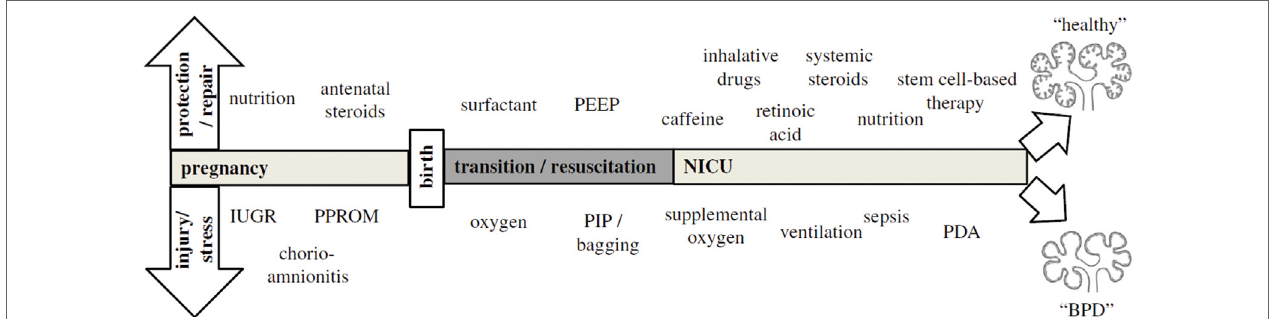
FigURe 1 | The pathogenesis of bronchopulmonary dysplasia (BPD) is highly multifactorial in nature, with a wide variety of pre- and postnatal exposures influencing lung development . Depending on the timing and combinations of exposures, BPD likely exists of multiple different pathophysiologies that manifest themselves in a similar way clinically. The top arrow represents exposures that may to a certain extent protect from BPD pathogenesis and promote repair, while the bottom arrow indicates exposures that injure the preterm lung and contribute to BPD pathogenesis. Figure reprinted from Hütten et al., originally published by Springer